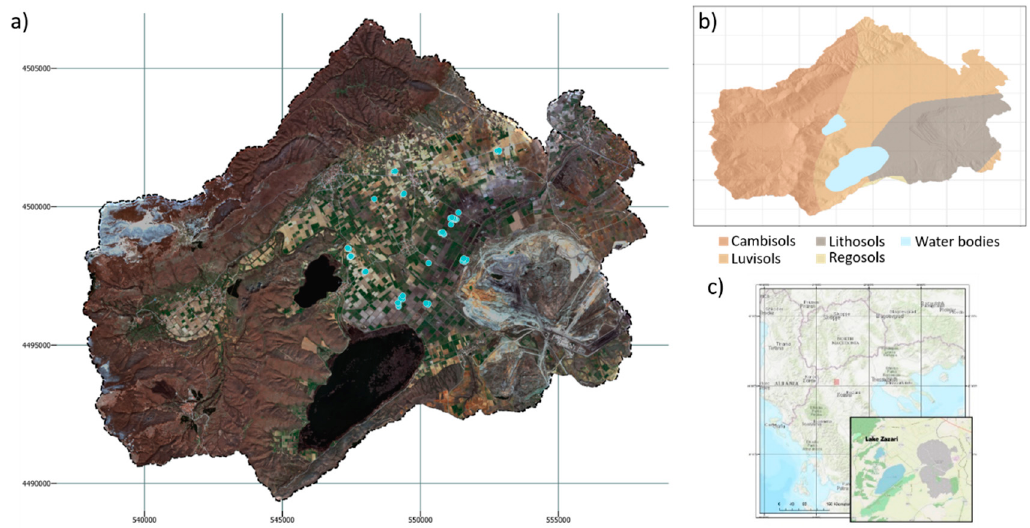
Table 2. Summary statistics of clay (%) for the selected mineral cropland soil samples of the LUCAS 2009 topsoil database and for the local dataset in Greece. Q1, Q2, and Q3 denote the first, second and third quartile, respectively.